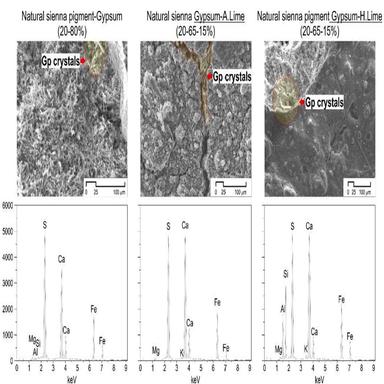
Photomicrographs obtained using a Scanning Electron Microscope (SEM) of gypsum mixed with natural sienna pigment PBr7 (80–20%), gypsum mixed with air lime and natural sienna pigment PBr7 (65–15-20%) and gypsum mixed with hydraulic lime and natural sienna pigment PBr7 (65–15-20%). The lower section contains the associated EDX element analysis for the central area of the sample. In all cases, the scale represents 100 µm.